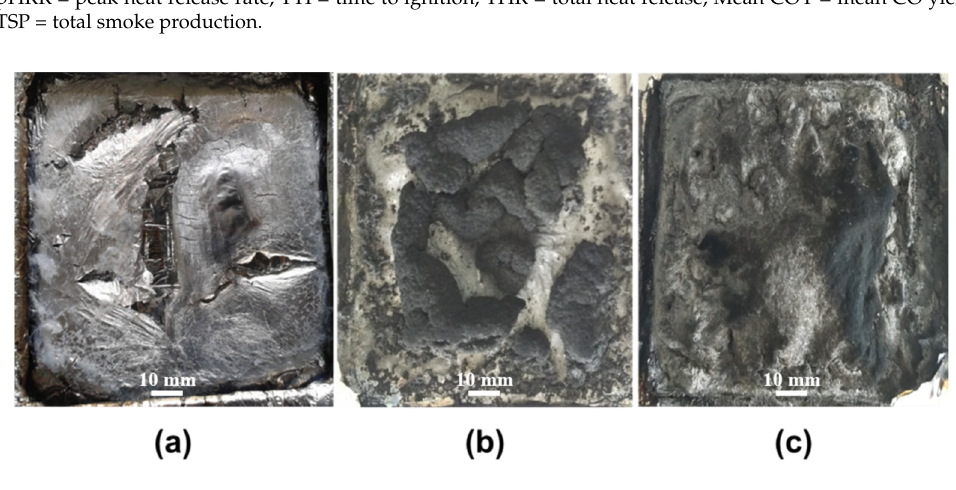
Figure 4. Digital photographs of PLA and PLA composites after CONE test from a horizontal per- spective: A1C1M0 ( a ) and A2C1M1 ( b ). 3.2. Thermal Stability The TGA curves of PLA and PLA composites under N 2 and air atmospheres are shown in Figure 5. Under a N 2 atmosphere (Figure 5a), neat PLA sample exhibited a one- step decomposition routine from 320 to 410 °C. For the C20 and A1C1M0 samples, a two- step degradation process was obtained. The first step around 300 °C corresponded to the